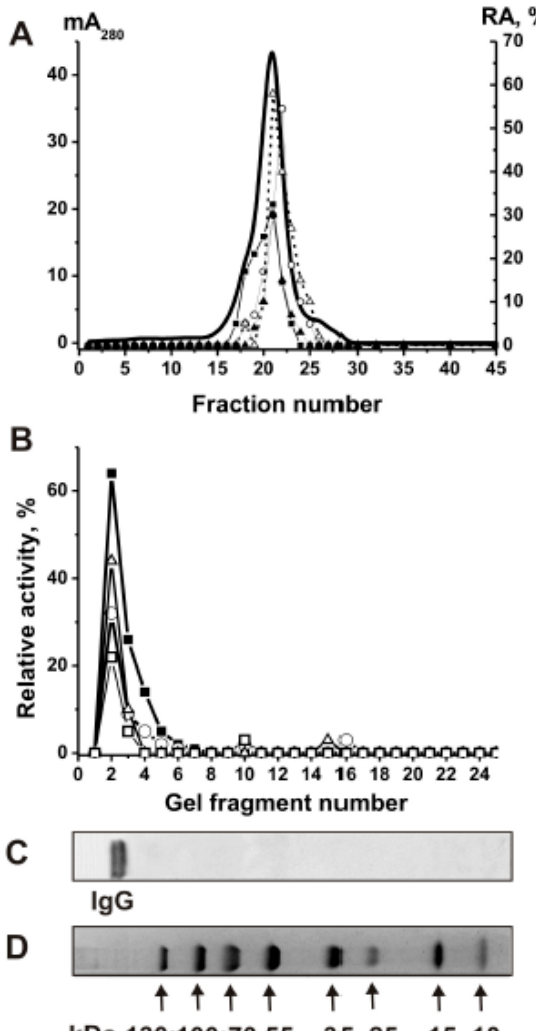
Figure 2. Verification of the strict criteria proving that IgG mix hydrolyze histones. Fast protein liquid gel filtration chromatography (FPLC) gel filtration of MS IgG mix on a Superdex 200 column in glycine buffer (pH 2.6) after Abs pre-incubation using the same buffer. ( A ) (—), Absorbance at 280 nm (A 280 ); ( ■ , ○ , ∆ , ▲ ) relative activities (RAs) of IgG mix in the hydrolysis of H1, H2a, H2b, and H4, respectively. A complete hydrolysis of each histone for 16 h in the presence of 5 µ l of the eluates was taken for 100%. SDS-PAGE analysis of IgG mix in the hydrolysis of histones; ( B ) After non-reducing SDS-PAGE